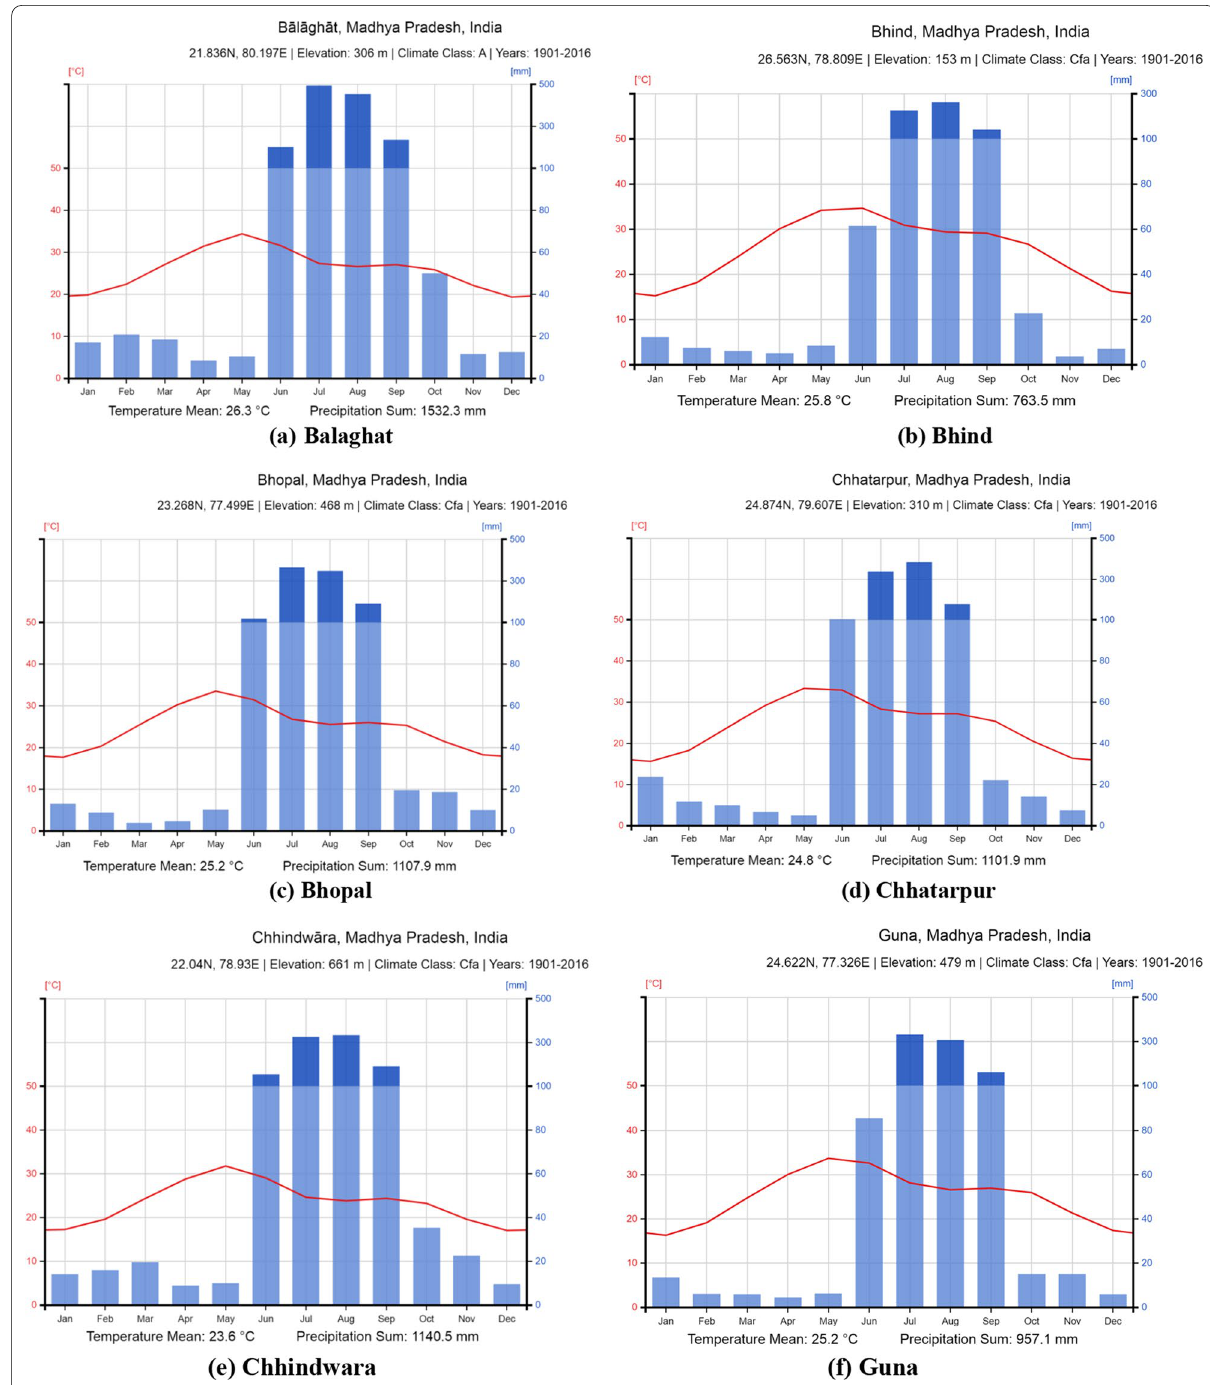
Fig. 4 Mean monthly temperature and precipitation (1901–2016) of the selected districts (Zepner et al. 2021). Mean monthly temperature and precipitation of each district for the 115 years duration are shown in figure a to m . The red line depicts the average temperature (°C) per month and the blue bars indicate the mean monthly rainfall in mm of each